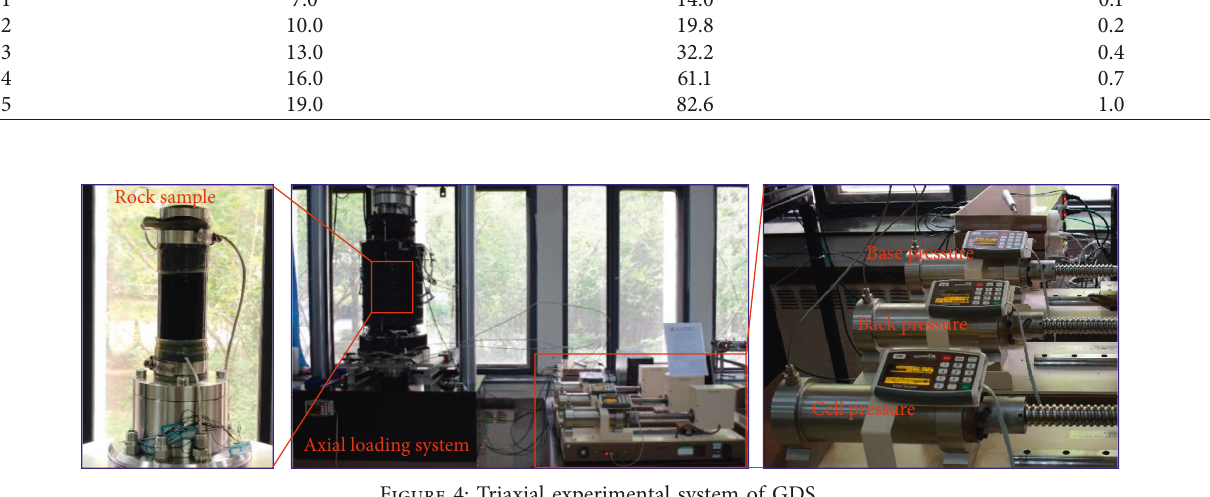
Figure 4: Triaxial experimental system of GDS.